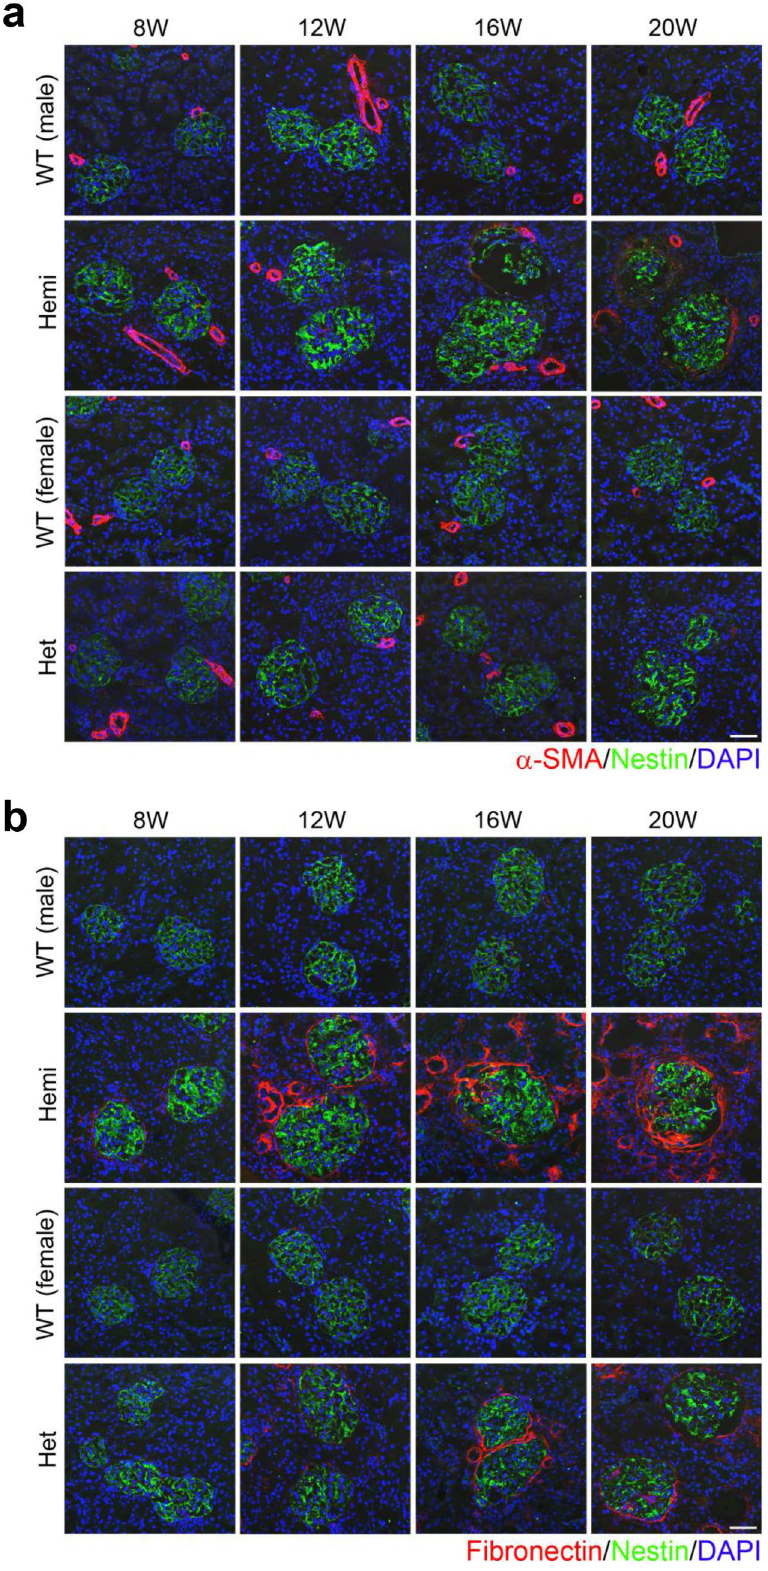
Figure 4. Renal fibrosis in Col4 α 5 deficient rats. (a,b) Immunostaining of kidney sections with α-SMA (a) or fibronectin (b) (red), nestin (green; glomeruli), and DAPI (blue; nuclei) in wildtype (WT) and Col4α5 mutant (Hemi; hemizygous males, Het; heterozygous females) rats from 8 to 20 weeks of age. Scale bars , 50